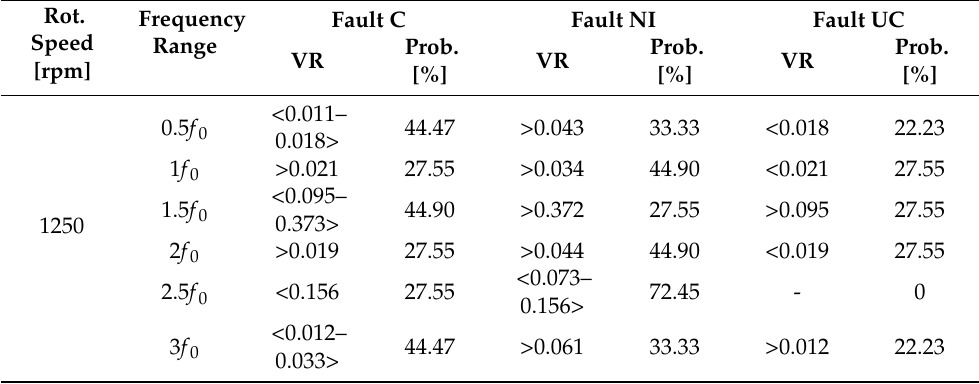
Table 4. Probability ranges for the diagnosis of the failure data for 1250 rpm, where C—efficient engine, NI—injection inefficient, UC—pressure inefficient, and VR—value range. Rot.